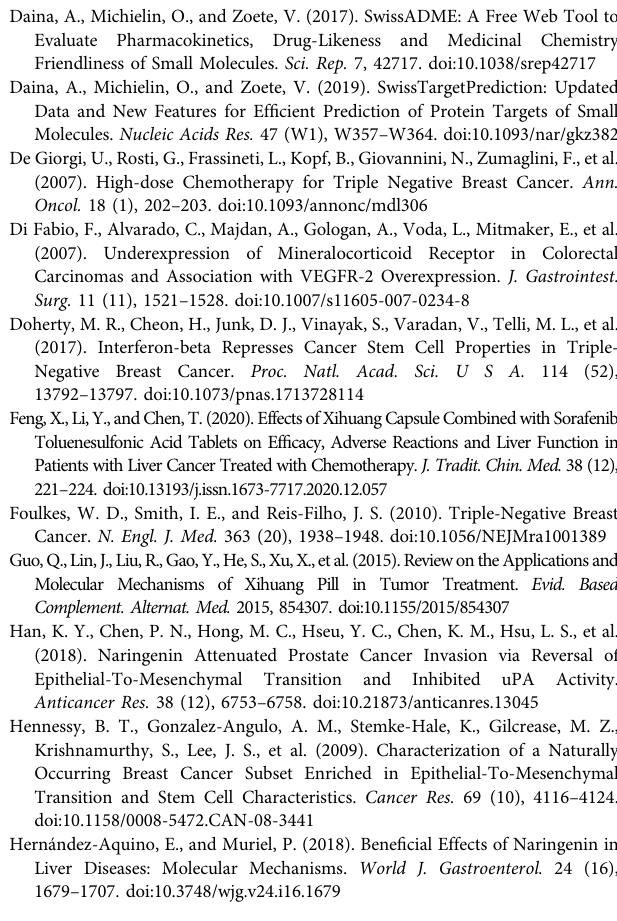
SUPPLEMENTARY FIGURE S2 | Subgroup survival analyses of the NR3C2 gene regardingOSusingtheTCGA –